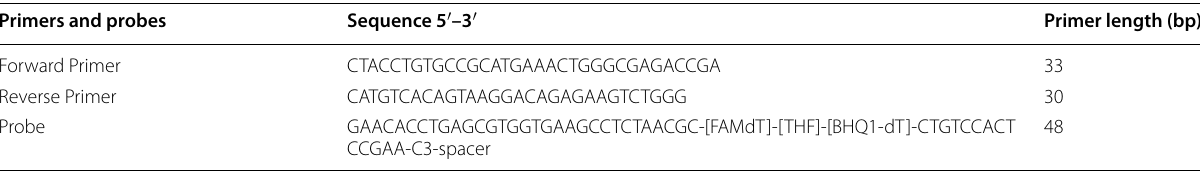
BHQ, black hole quencher; C3-Spacer, 3 ′ phosphate blocker; FAM, 6-carboxyforescein; THF, tetrahydrofuran.